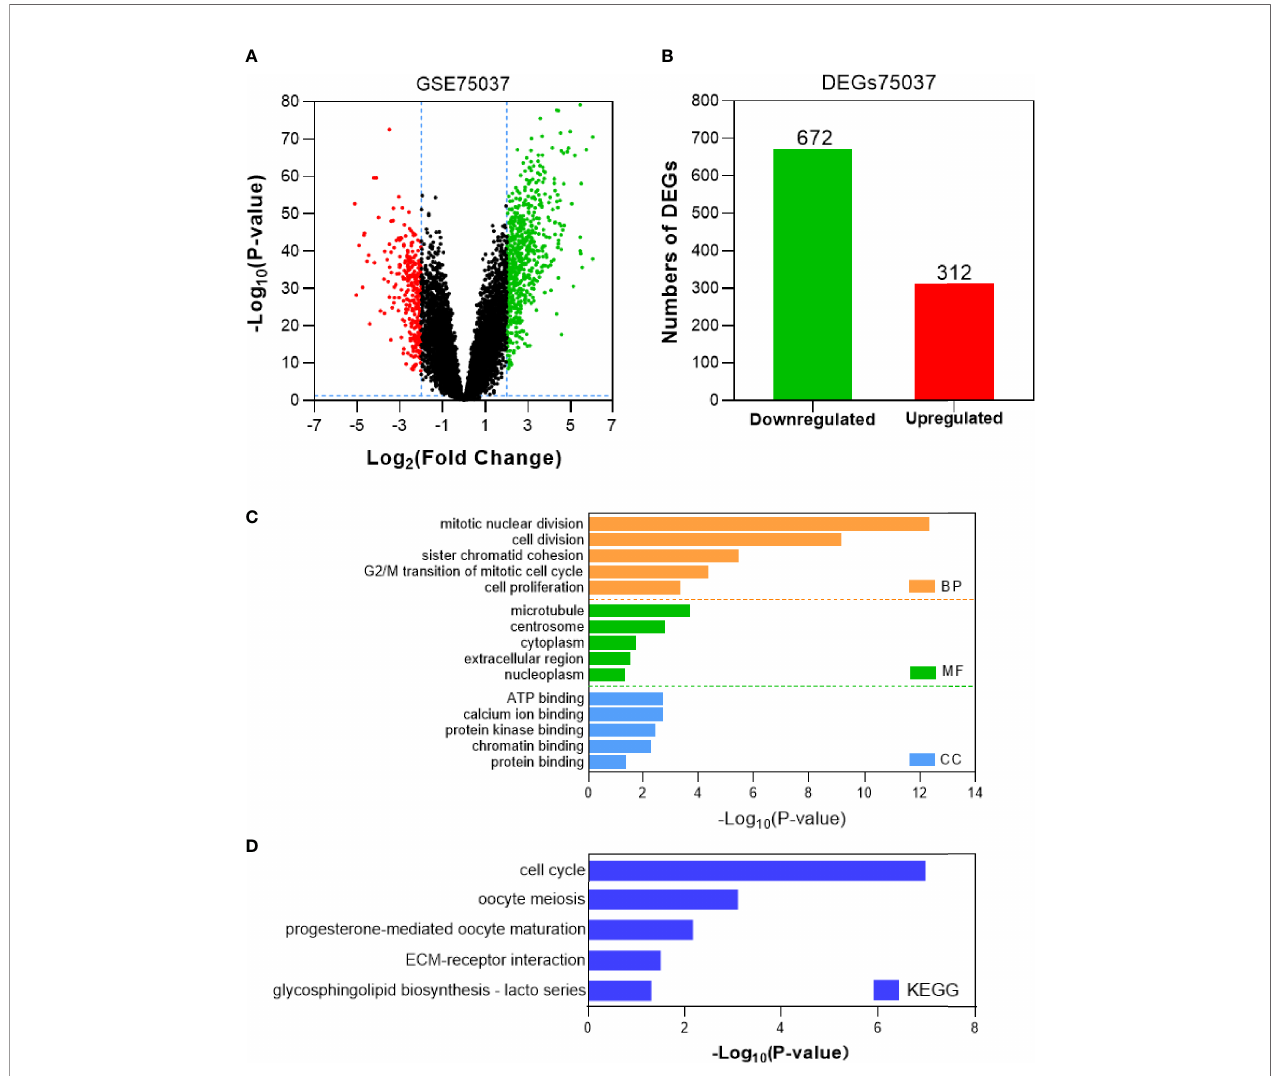
FIGURE 2 | Identi fi cation and characterization of DEGs from the GSE75037 dataset. (A) Volcano plot of DEGs between NSCLC tissues and adjacent normal tissues. Red dots are signi fi cantly upregulated DEGs in NSCLC tissues; green dots, DEGs downregulated in NSCLC tissues; black dots, genes with no signi fi cant difference (P<0.05 and |log2FC|>2 as the threshold). (B) Distribution of signi fi cant DEGs in NSCLC tissues. The top fi ve GO terms (C) and KEGG enriched pathways (D) of signi fi cantly upregulated DEGs in NSCLC tissues are indicated. BP, biological process; CC, cell component; MF, molecular